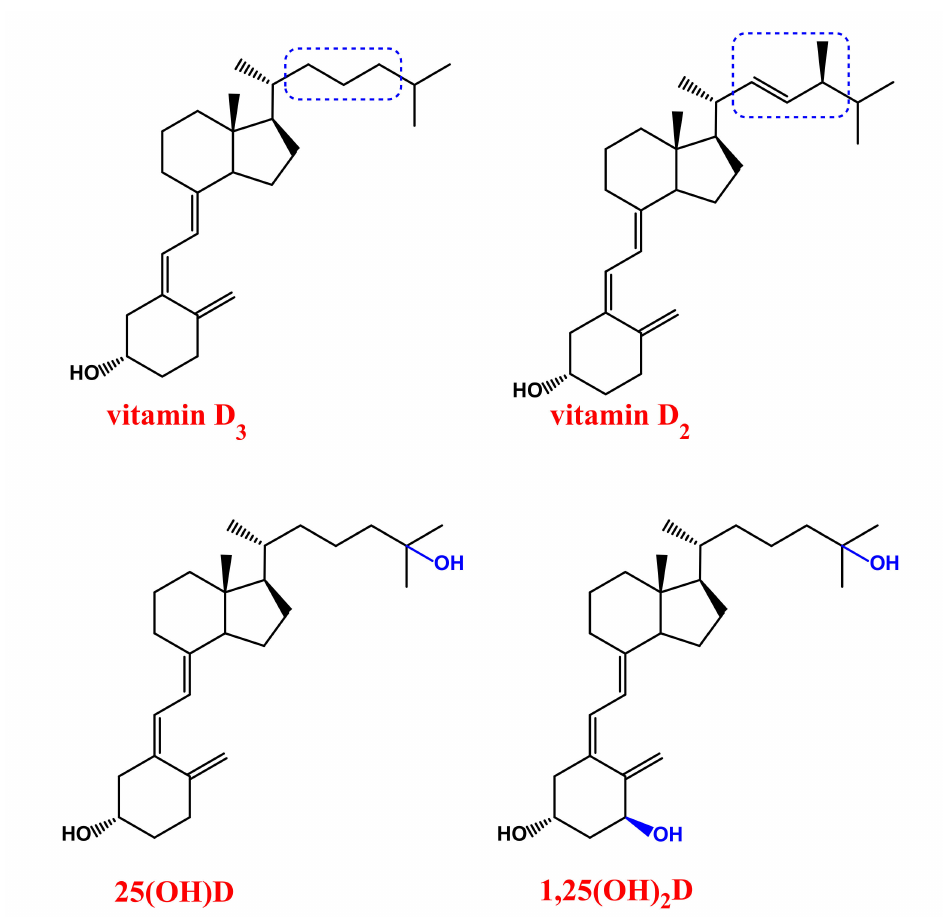
Figure 1. Chemical structures of vitamin D 3 , D 2 , 25(OH)D and 1,25(OH) 2 D. Structural di ff erences are highlighted in blue. 25(OH)D: 25-hydroxy-vitamin D or calcidiol; 1,25(OH) 2 D: 1,25-dihydroxy-vitamin D or